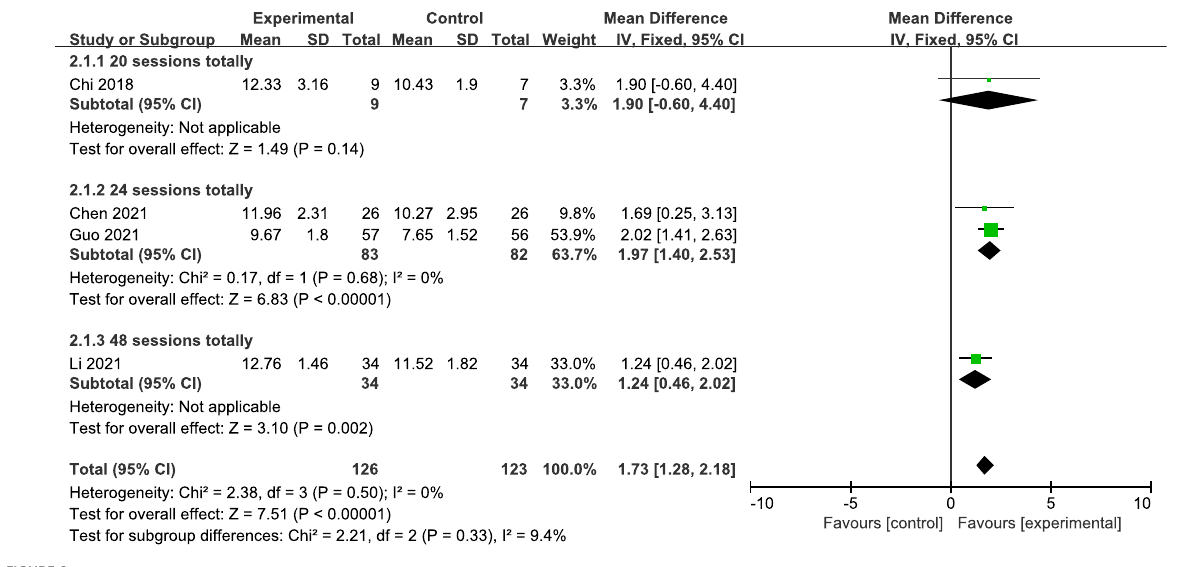
FIGURE6 Subgroup analysis of stimulation doses on GCS scores in patients with DOC.